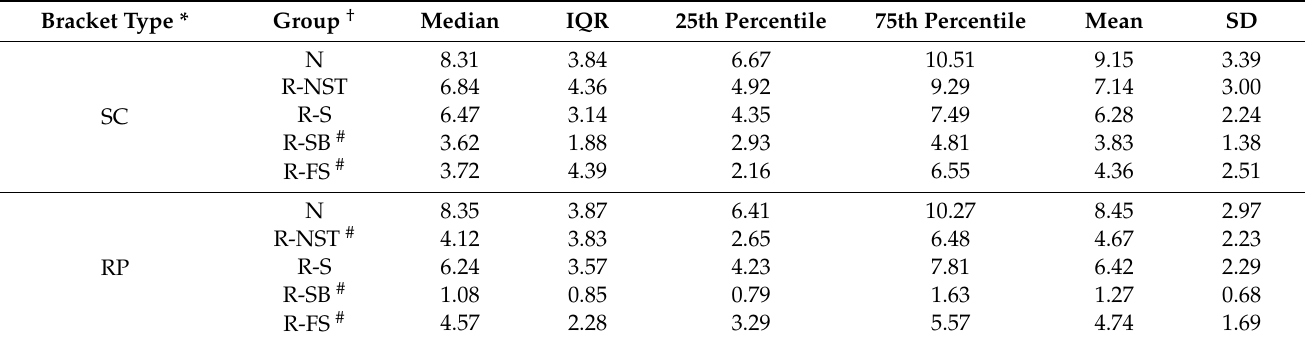
Table 1. Shear bond strengths (MPa) of newly bonded and rebonded brackets.